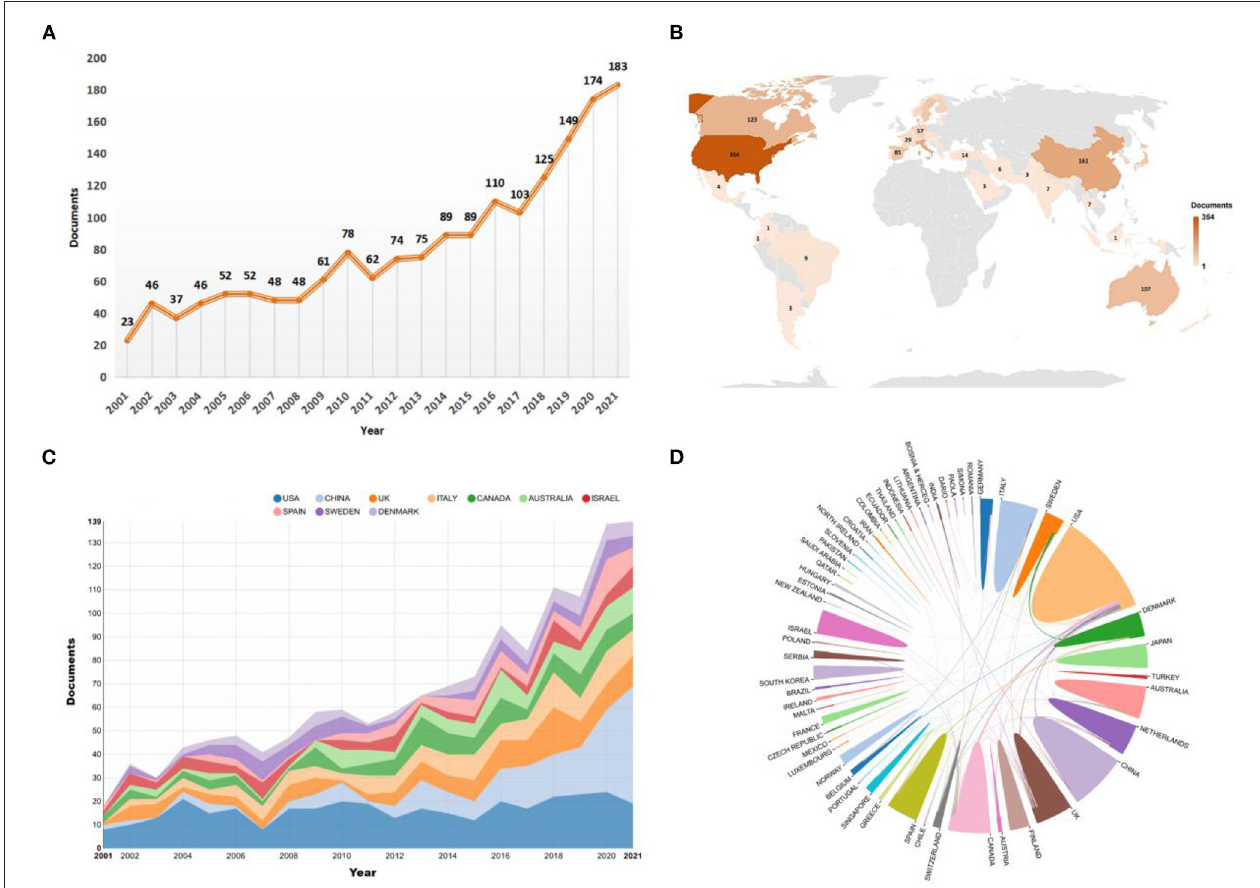
FIGURE 2 | (A) The number of annual publications on rehabilitation of hip fracture from 2001 to 2021. (B) A world map depicting the contribution of each country based on publication counts. (C) The annual number of publications in the top 10 most productive countries from 2001 to 2021. (D) International collaboration analysis among different countries/regions. (C,D) was generated from an online analysis platform (https://bibliometric.com).